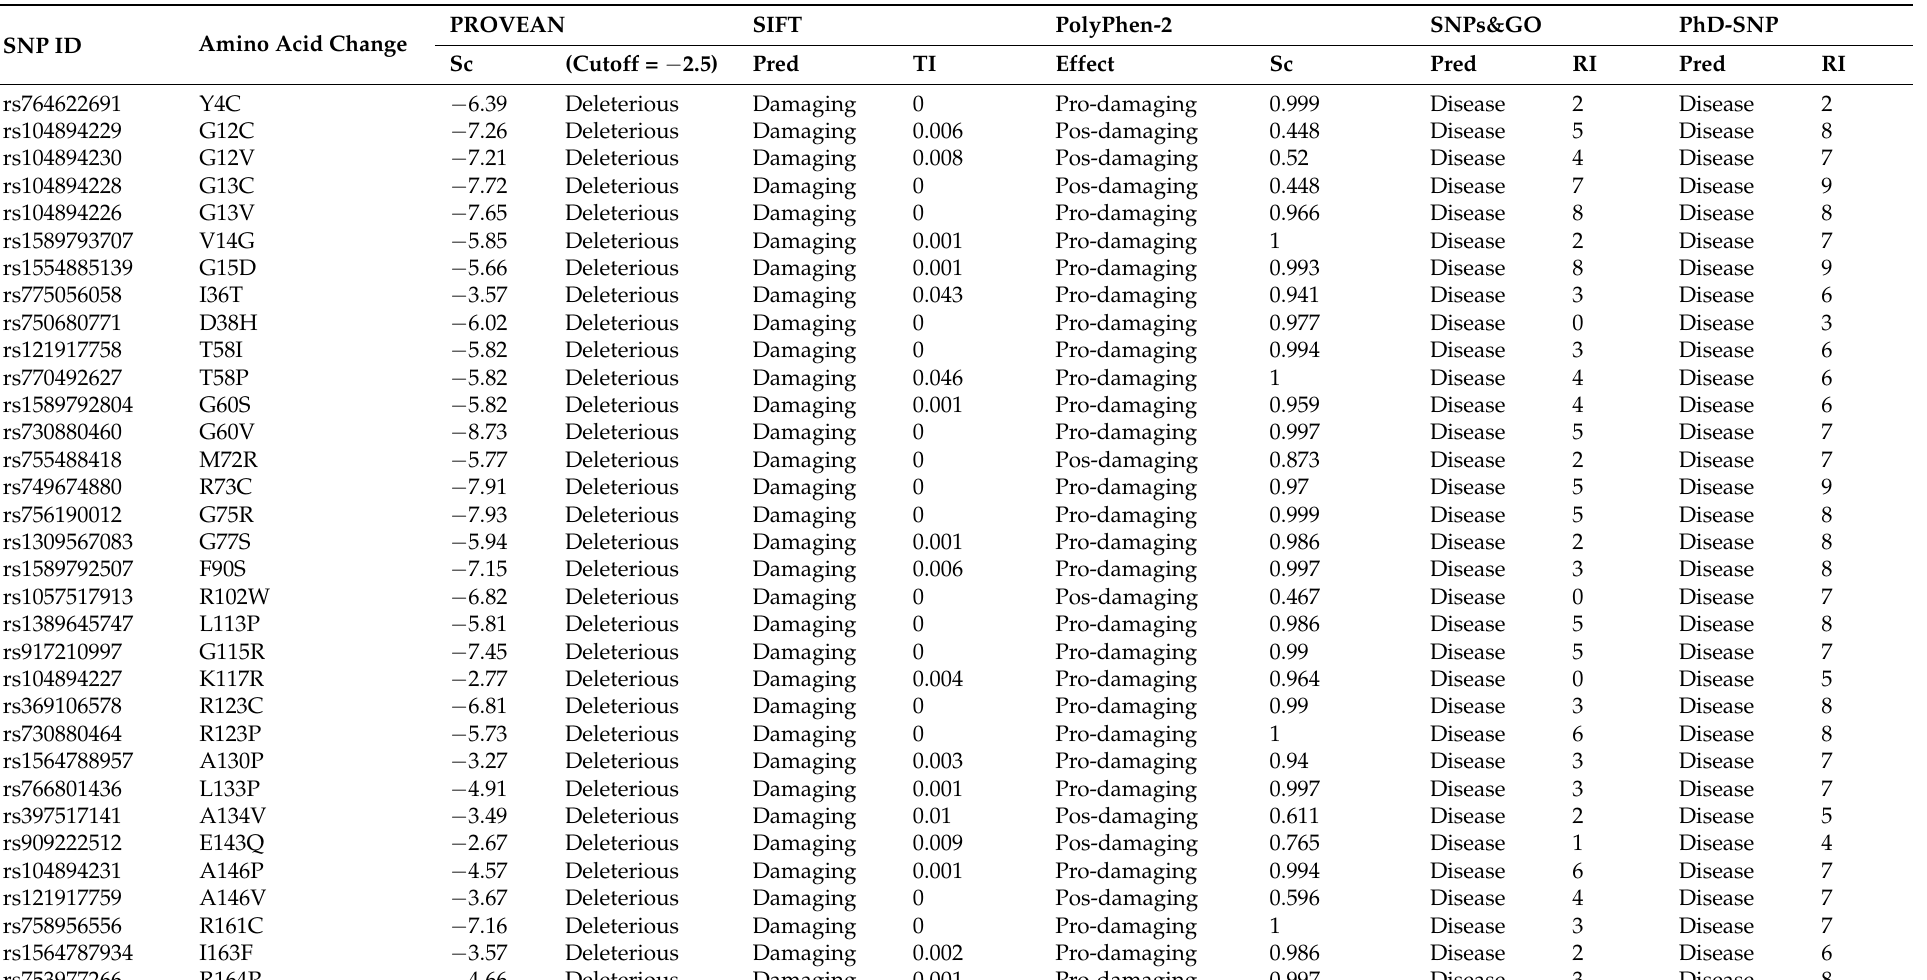
Table 1. High-risk nsSNPs identified by five in silico